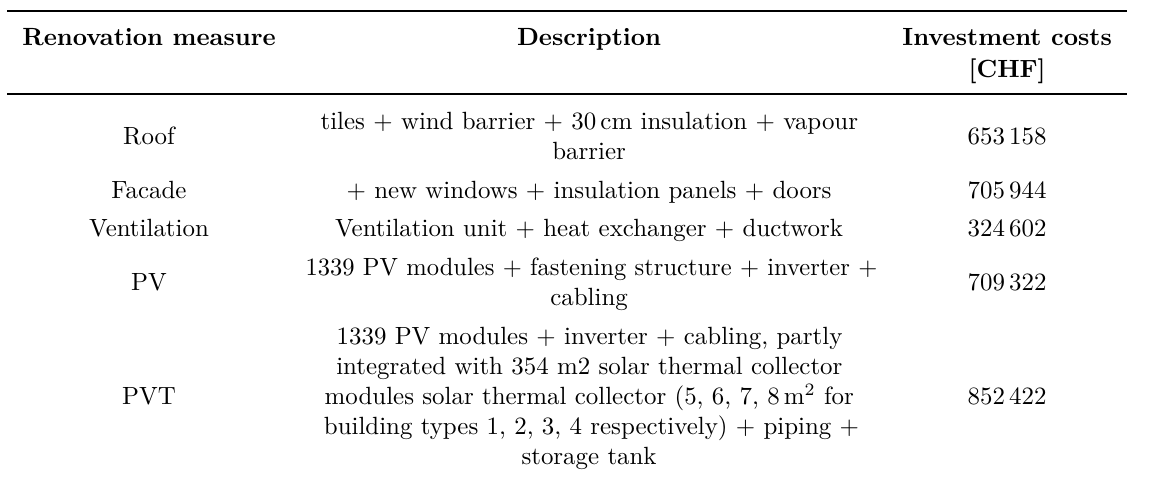
Table 7. Renovation measures with investment costs.